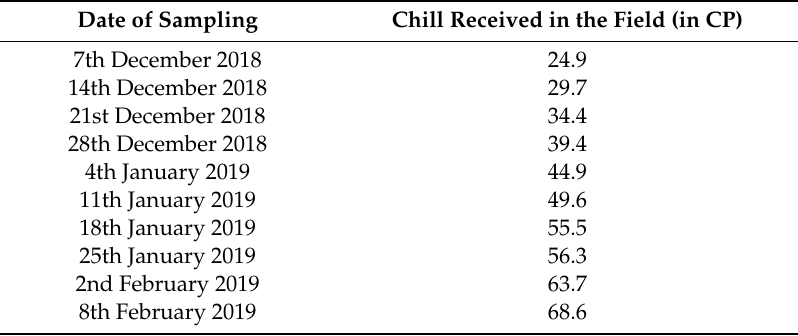
Table 1. Chill accumulation (in Chill Portions (CP)) in the orchard according to the Dynamic